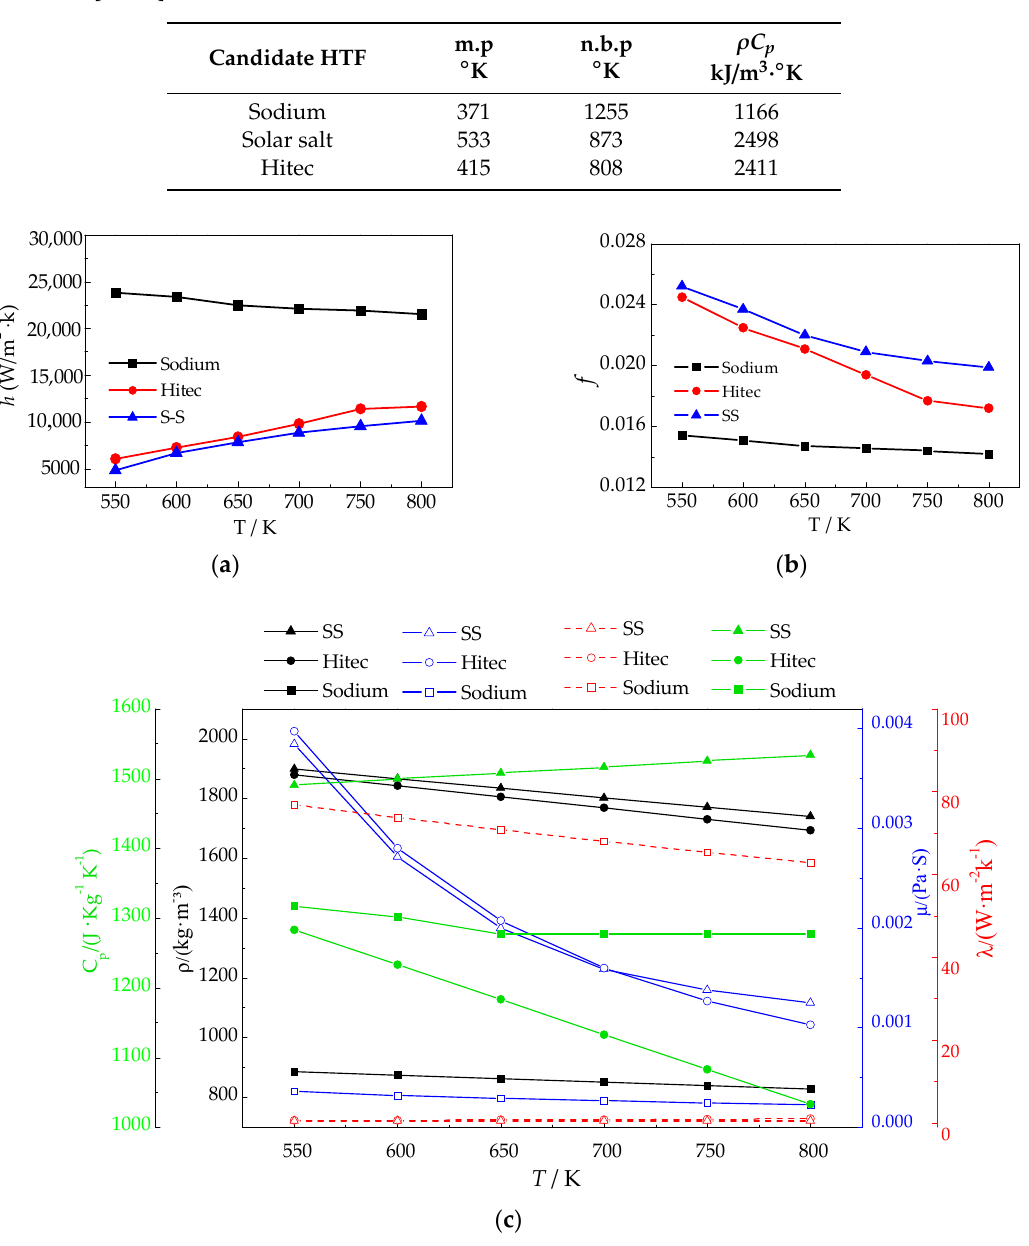
Table 3. Comparison of the physical properties for di ff erent HTFs proposed for CRS applications. The physical properties are evaluated at 550 ◦ K, 1 bar. melting point = m.p, normal boiling point (n.b.p). Sources: [35–37].